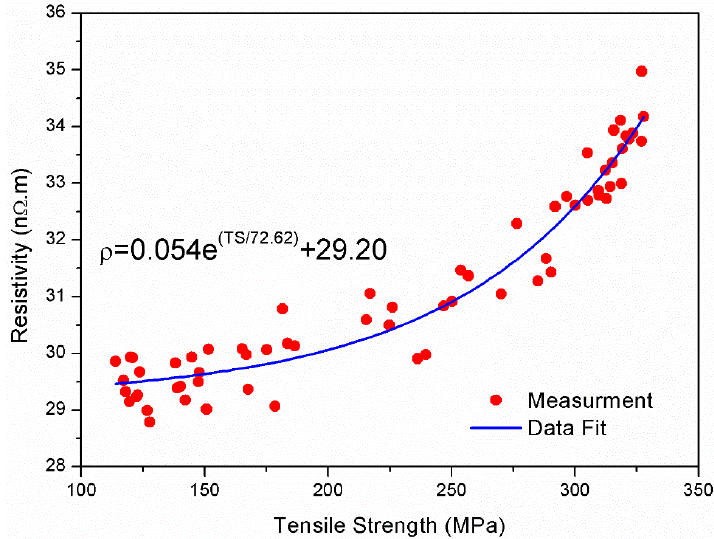
Figure 6. Relationship between electrical resistivity and tensile strength of 1.7 mm wires.